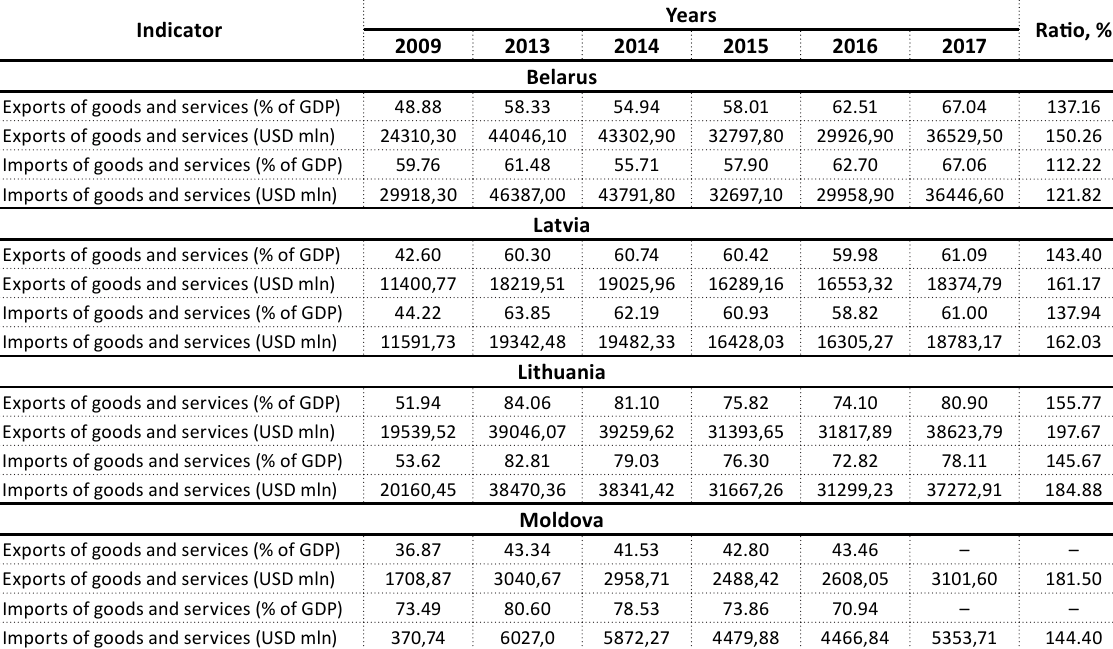
Table 1. Comparative dynamics of export-import operations of Eastern European countries Source: Authors’ calculations according to the data from the World Bank.